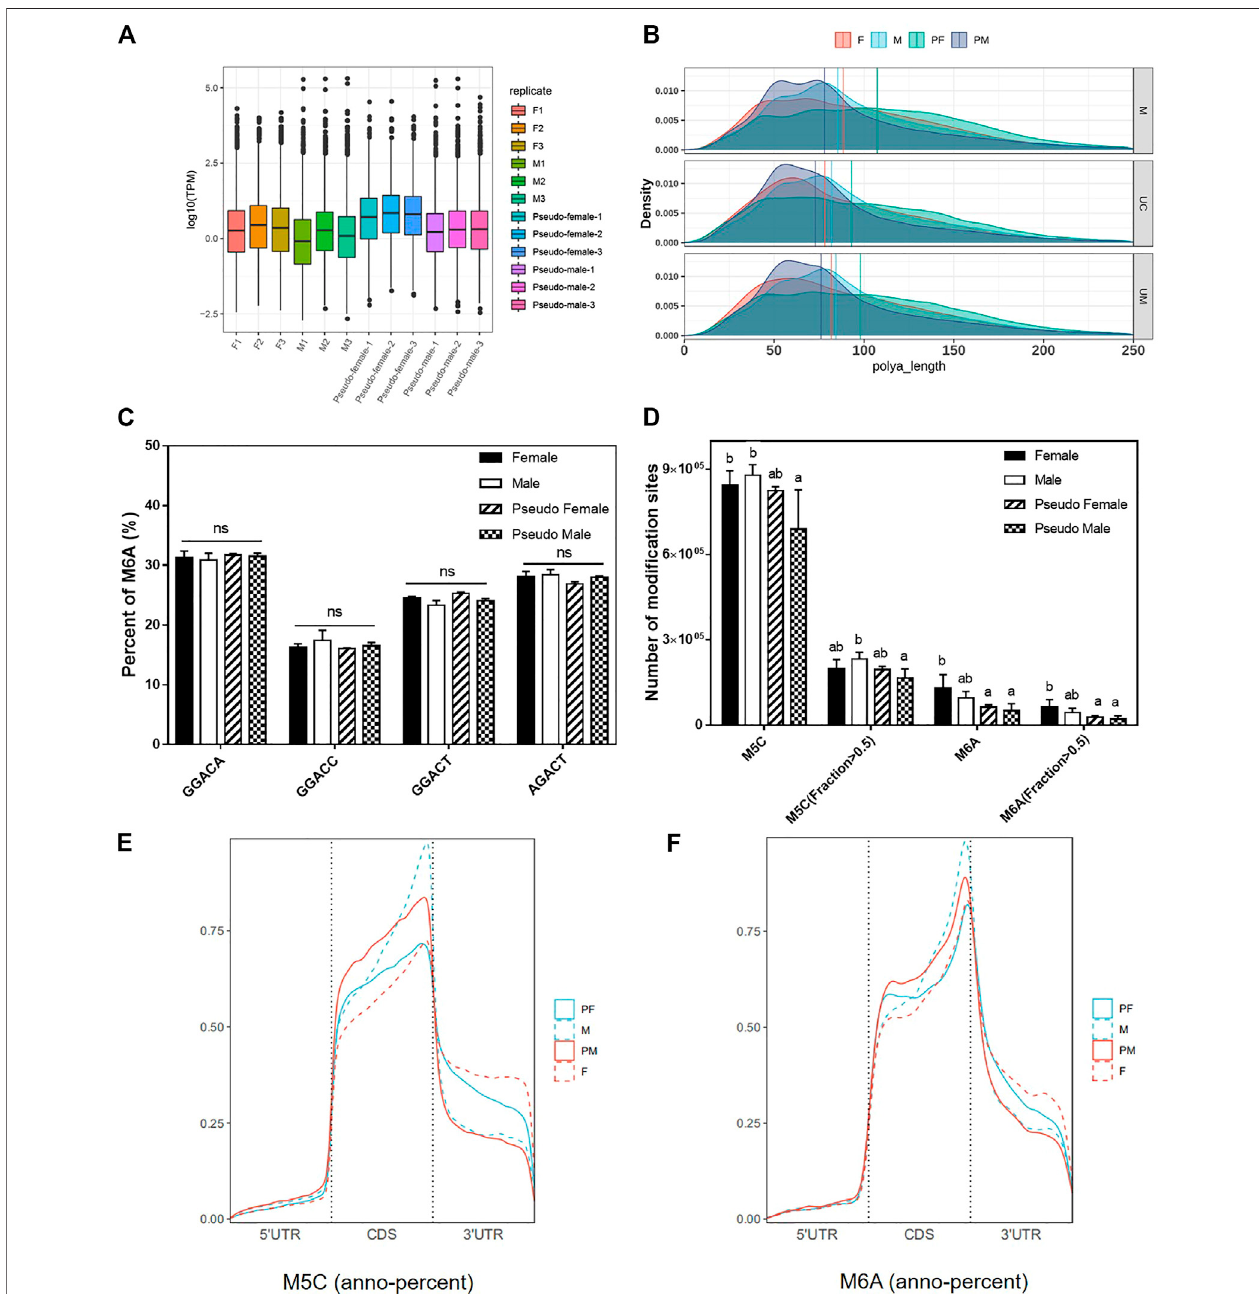
FIGURE 4 | Methylation analysis of P. sinensis gender types. (A) The distribution and overall expression levels of transcripts with m6A modi fi cations of different samples. (B) Thecorrelationanalysisbetweenpoly(A)lengthandtranscriptswithm6Amodi fi cationofdifferentsamples. (C) Thepercentageofdifferentm6Amethylation types of P. sinensis gendertypes. (D) The number of m5Cand m6Amodi fi cation sites of P.sinensis gender types. (E) The percentage of m5Cmethylation annotation in different positions. (F) The percentage of m6A methylation annotation in different positions. Data were expressed as mean ± SD. Different superscripts indicate signi fi cant difference ( p < 0.05). ns, no signi fi cant difference.